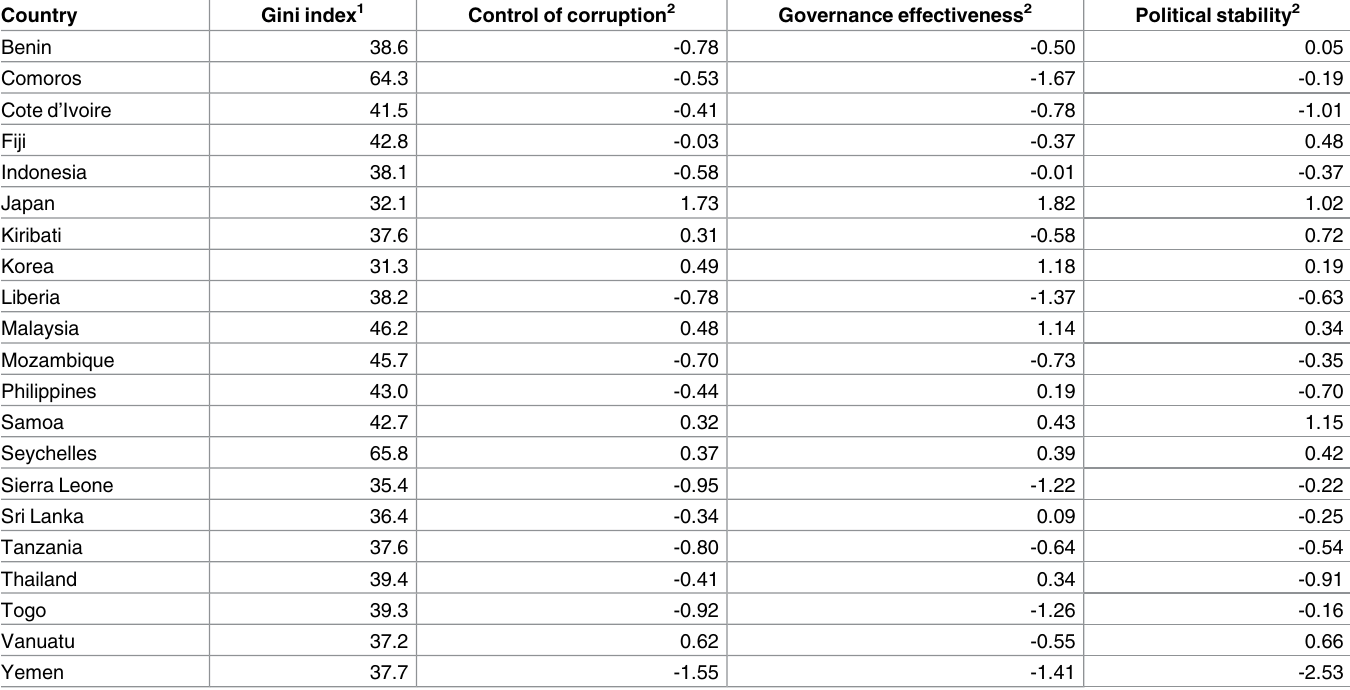
Table 6. Summaryof Gini coefficient and governance indicators for countries projected to experience net catch losses.